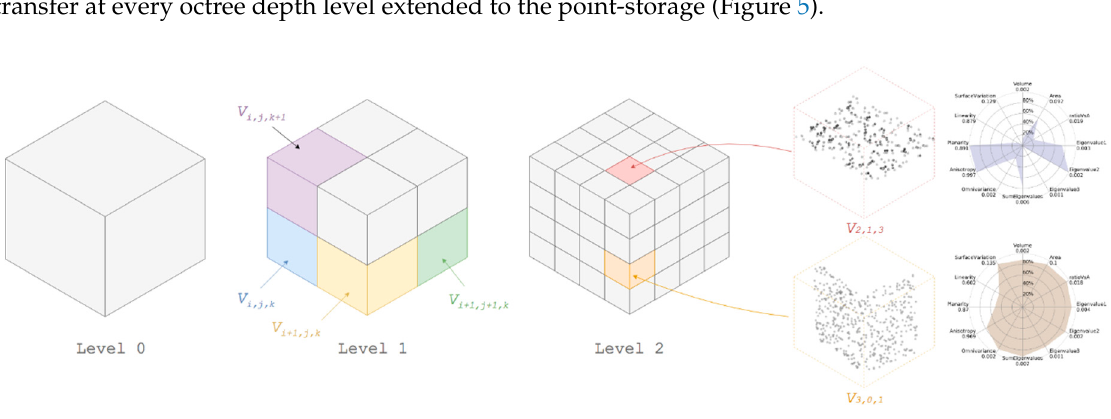
Figure 5. Feature transfer between octree levels. We note that each non-empty node describes a voxel which can then permit a point-level access for example to compute feature sets (here, a planar voxel and a corresponding SF1 sample, and a transition voxel and its corresponding SF1 sample).